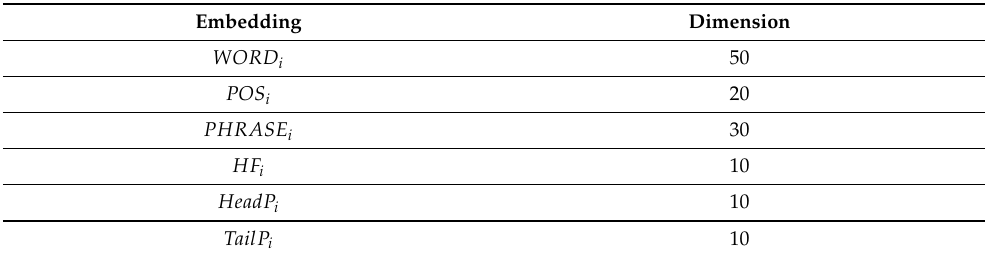
Table 1. The dimension of important